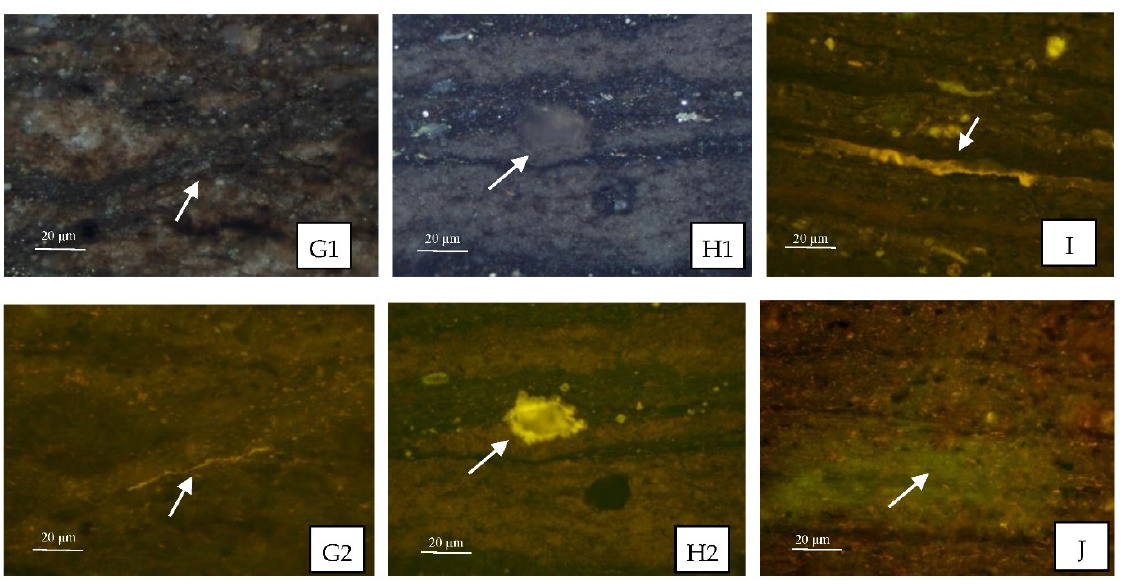
Figure 4. Representative micrographs of some studied samples. ( A1 , A2 ) Reflected light and fluorescence photos, respectively, for the same field of sample FY1-1, displaying telalginite with strong yellow fluorescence, lamalginite and its debris with yellow fluorescence, mineral–bituminous groundmass with brownish yellow fluorescence, and bitumen filling micro-fissures along the bedding plane with brown fluorescence. ( B1 , B2 ) Reflected light and fluorescence photos, respectively, for the same field of sample FY1-7, indicating fluorescence occurring along the bedding plane with yellow-green fluorescence. ( C1 , C2 ) Reflected light and fluorescence photos, respectively, for the same field of sample FY1-8, indicating fluorescence occurring in mineral-hosted pores with strong yellow fluorescence. ( D1 , D2 ) Reflected light and fluorescence photos, respectively, for the same field of sample NY1-2, showing lamalginite and its debris with yellow fluorescence, mineral–bituminous groundmass with brown-yellow fluorescence, and fluorescence occurring along the bedding plane with yellow fluorescence. ( E1 , E2 ) Reflected light and fluorescence photos, respectively, for the same field of sample NY1-6, indicating lamalginite with yellow fluorescence, and fluorescence occurring around the edge of pores with yellow fluorescence. ( F1 , F2 ) Reflected light and fluorescence photos, respectively, for the same field of sample NY1-5, indicating telalginite with yellow fluorescence. ( G1 , G2 ) Reflected light and fluorescence photos, respectively, for the same field of sample LY1-1, showing mineral–bituminous groundmass with dark brown fluorescence, a large amount of lamalginite debris with brown fluorescence, and fluorescence with brown-yellow fluorescence. ( H1 , H2 ) Reflected light and fluorescence photos, respectively, for the same field of sample LY1-9, indicating fluorescence occurring around the edge of pores with yellow fluorescence. ( I ) Fluorescence photo from sample LY1-7, indicating fluorescence occurring along the bedding plane with yellow fluorescence. ( J ) Fluorescence photo from sample LY1-8, indicating a large amount of lamalginite debris with brown fluorescence, and an oil halo with green fluorescence, which was formed on the sample surface under blue light excitation.